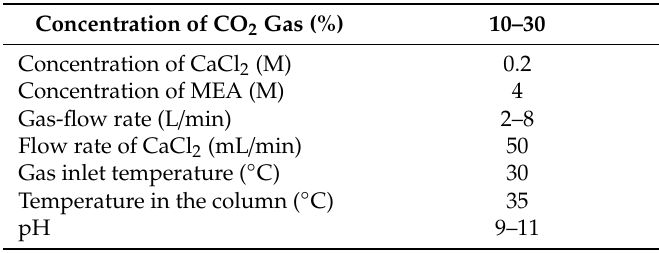
Figure 1. The capture of CO 2 using a bubble-column scrubber. 1. CO 2 gas tank; 2. N 2 gas tank; 3. gas-flow meter; 4. gas-flow meter; 5. digital pressure gauge; 6. bubble-column scrubber; 7. cooling machine; 8. tubing pump; 9. controller; 10. thermometer; 11. pH-electrode; 12. CO 2 meter; 13. MEA solvent reservoir; 14. reservoir; 15. cooling coil; 16. tubing pump; 17. CaCl 2 solution reservoir. Table 1. Operating conditions used in this work.